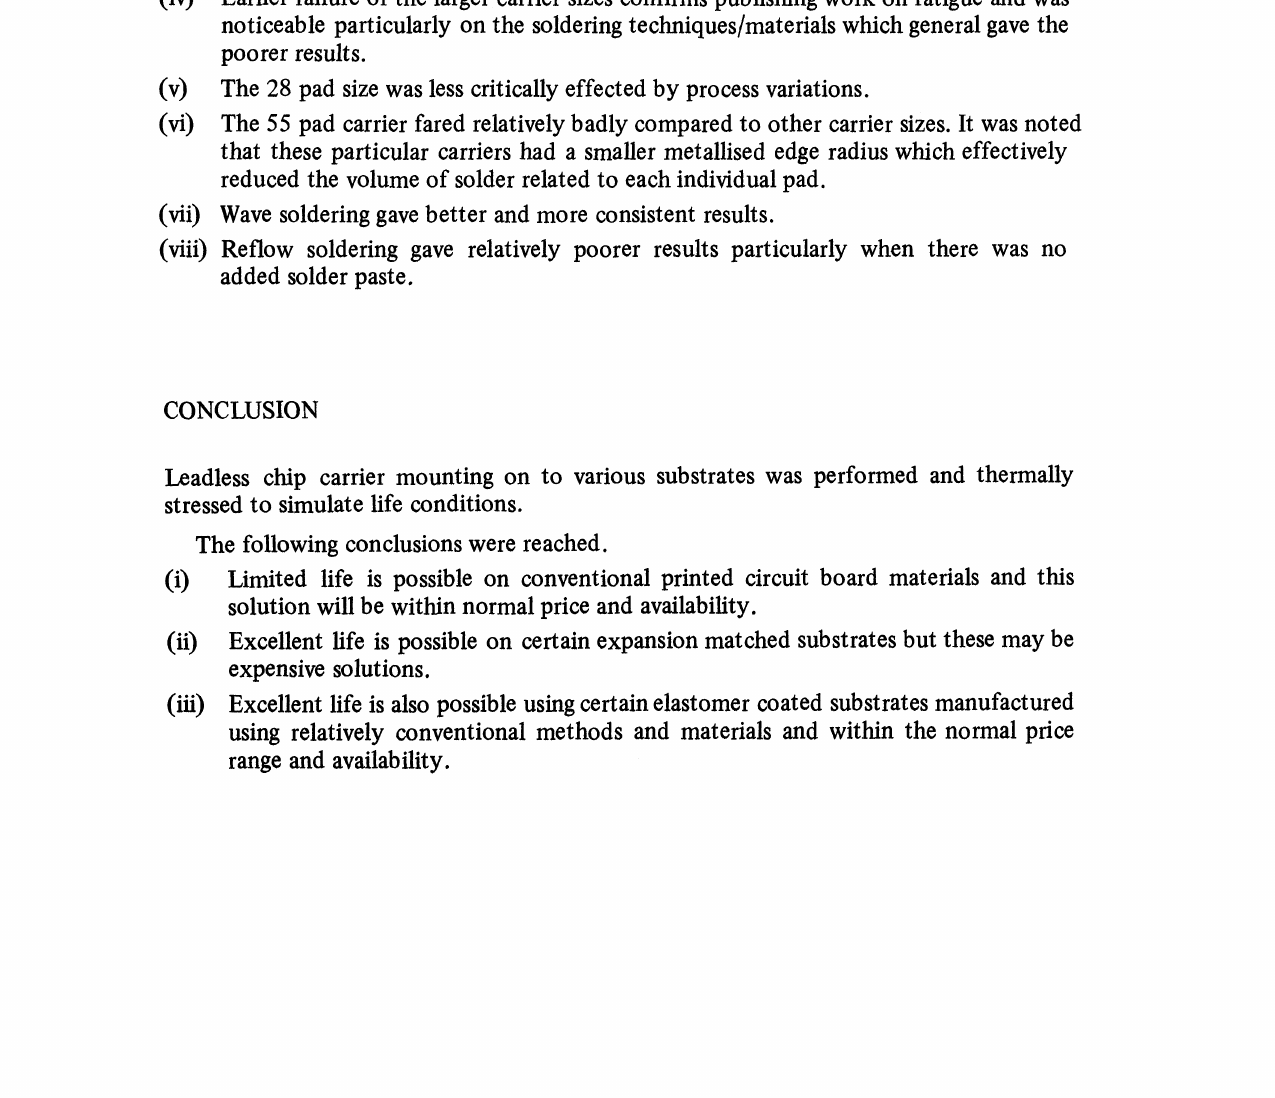
FIGURE 8 Thermal Cycling Performance of 28 Pad Carriers (432 cycles -55C to